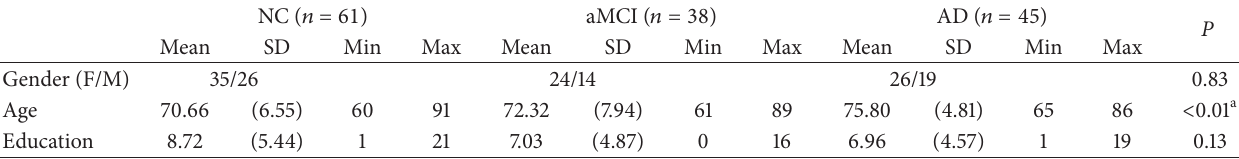
Table 1: Demographic characteristics of the sample divided into diagnostic groups.